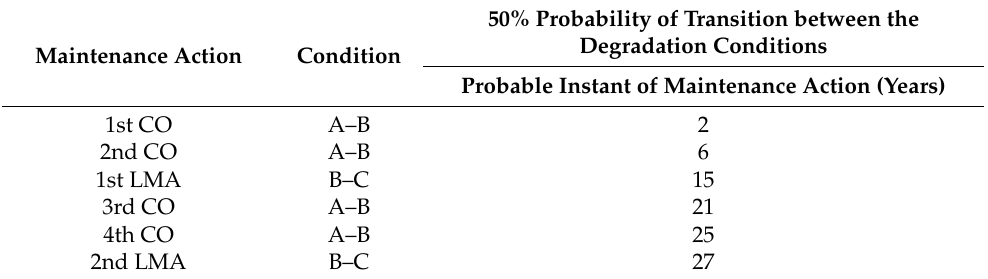
Table 5. Instants for the maintenance actions in ETICS considering the third maintenance strategy (MS3), considering a time horizon of 40 years.